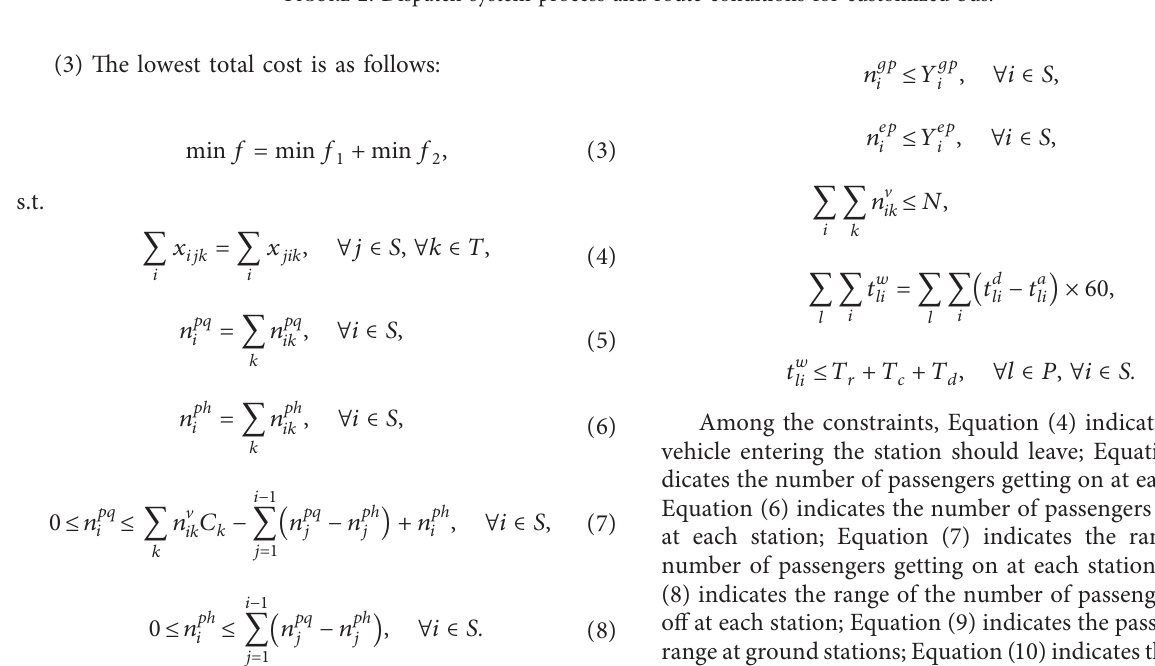
Figure 2: Dispatch system process and route conditions for customized